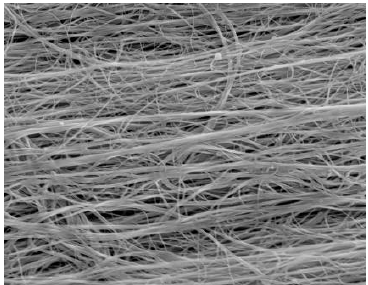
Figure 8. SEM image showing the surface of an aligned carbon nanotube Bucky-paper (5 kV, 5 mm working distance).